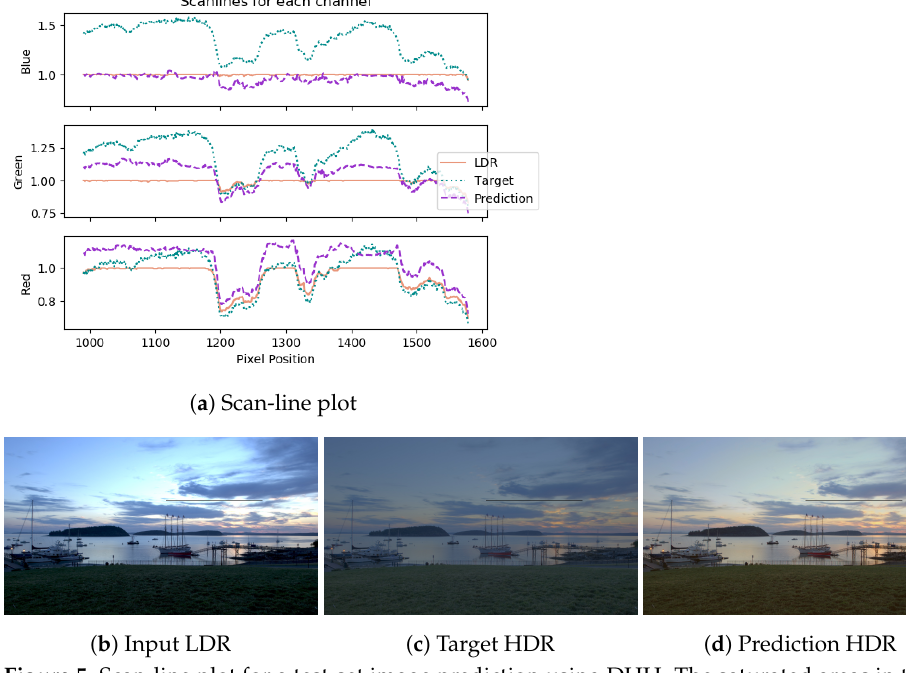
Figure 5. Scan-line plot for a test-set image prediction using DHH. The saturated areas in the LDR are reconstructed well in the prediction and correlate with the target